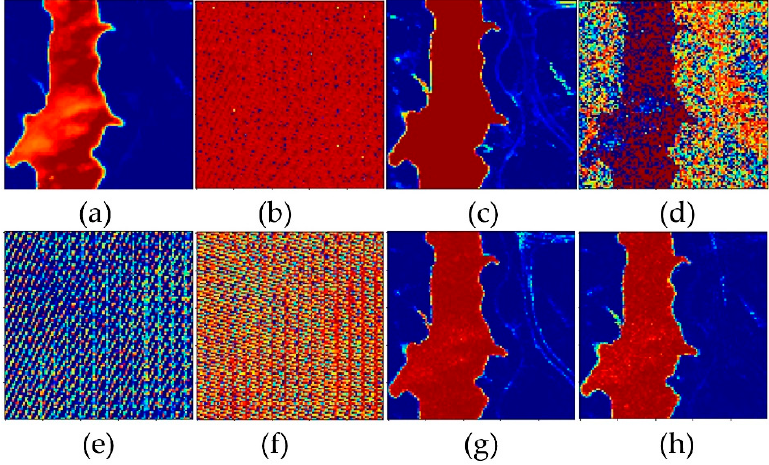
Figure 8. Estimated maps of the endmember “Dirt” when 30% samples of the noisy data are utilized for training. ( a ) Ground truth; ( b ) CNN; ( c ) STFHU; ( d ) STCNN; ( e ) ResNet; ( f ) AResN; ( g ) RNST; and